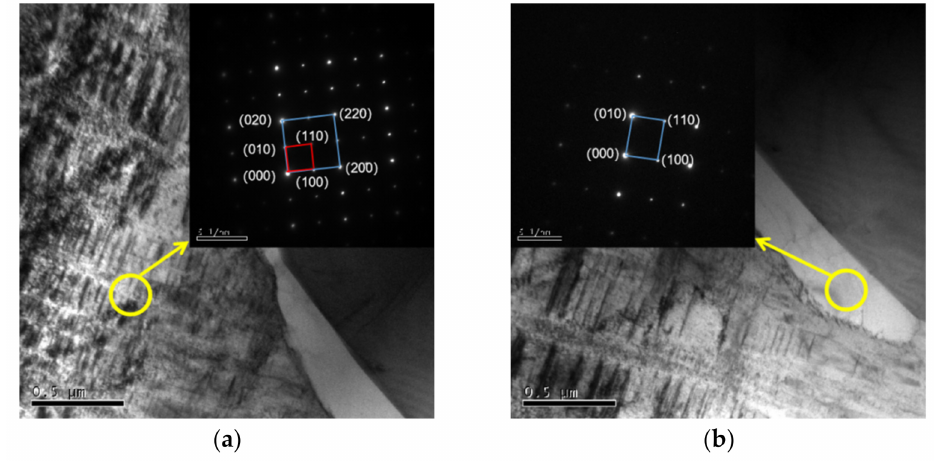
Figure 6. TEM analysis of Fe-25Mn-13Al-8Ni-C alloy, ( a ) austenite phase; ( b ) k-carbide phase.